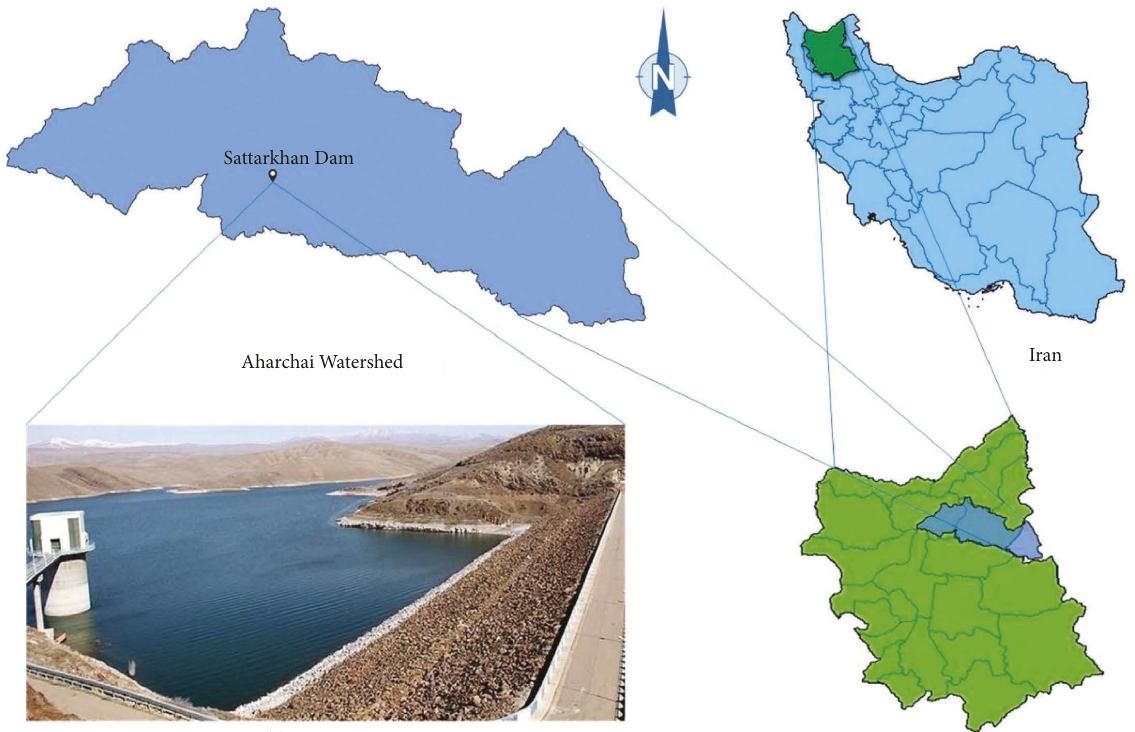
Figure 3: The geographic location of SattarKhan Dam.